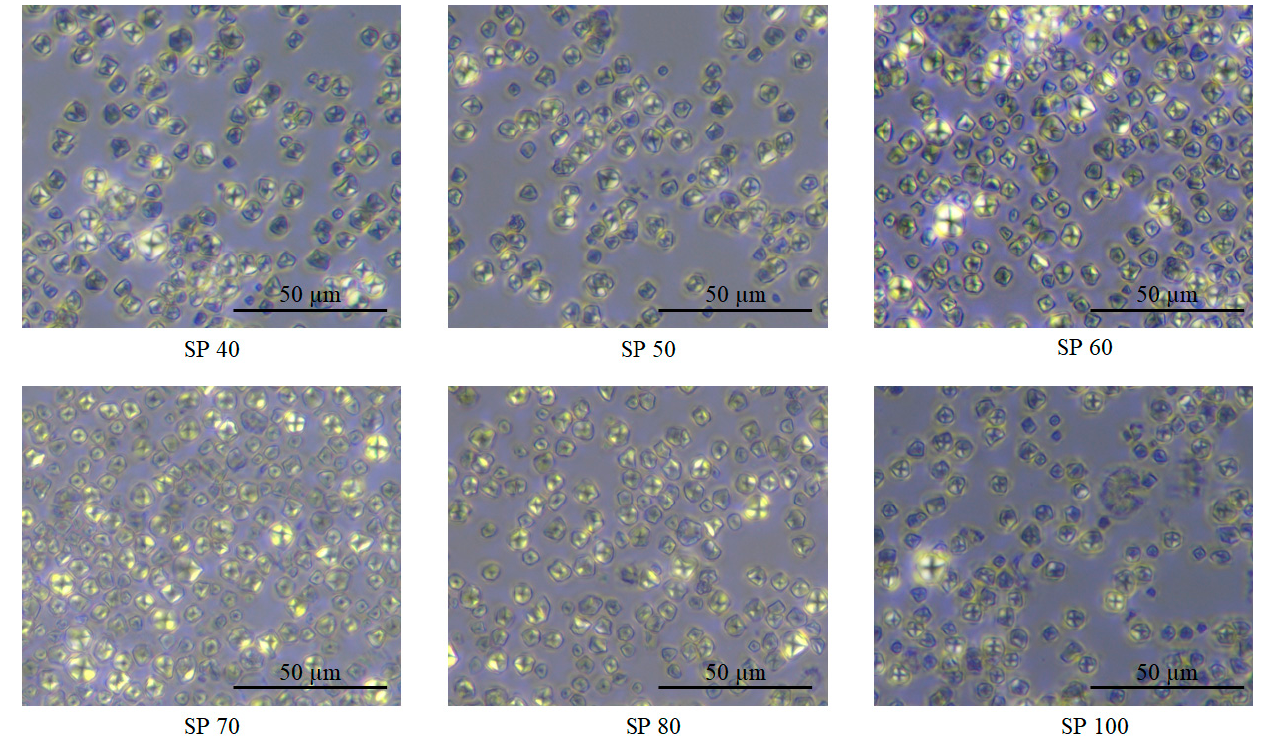
Figure 3. Spray dried waxy rice starches observed under polarized light microscope at 40× magnification.